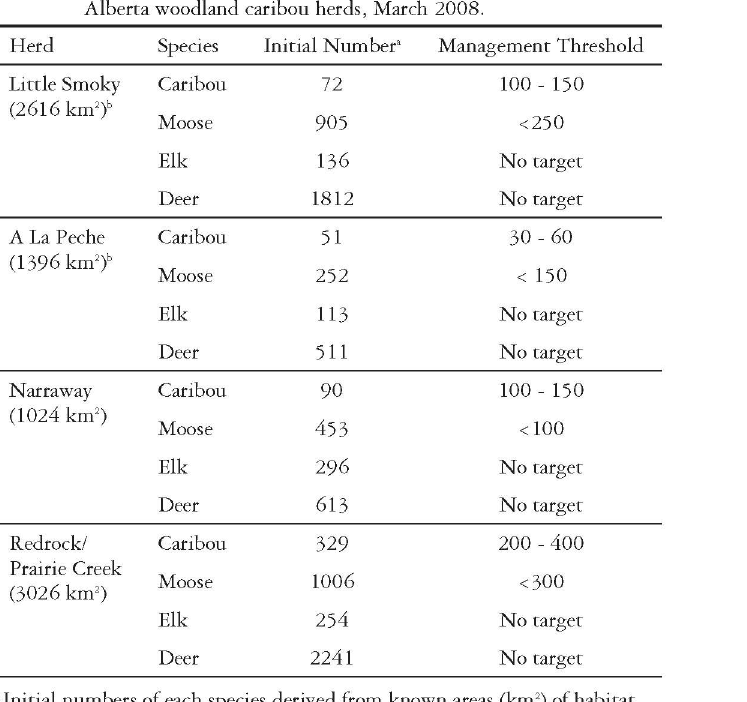
Table 5. Initial population numbers and management thresholds of species described in REMUS © simulation modeling for 4 west central Alberta woodland caribou herds, March